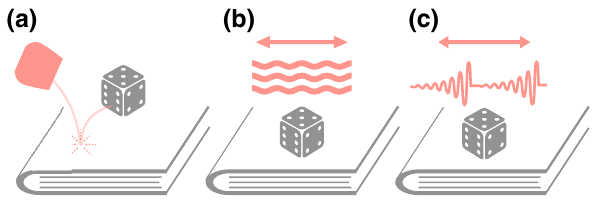
FIG. 1. Classical die processes. (a) Fair toss; (b) perturbed toss; and (c) the perturbation strength depends on the